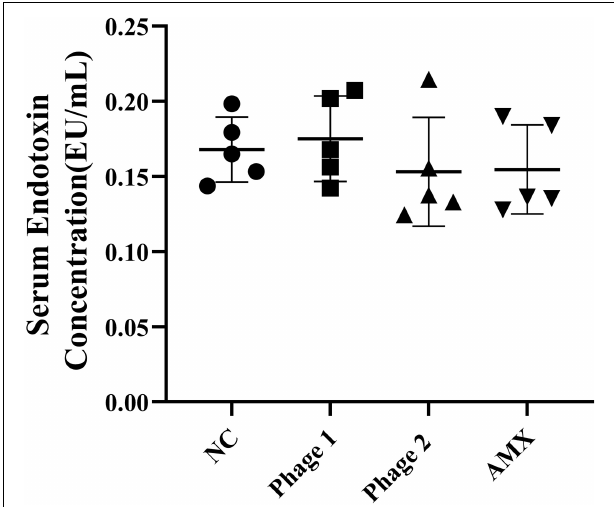
FIGURE 4 | Effect of phage on serum endotoxin in chicks ( n = 5). The serum endotoxin level is an important biomarker of intestinal permeability and was detected using an ELISA kit. NC, negative control; Phage 1, 10 9 PFU GRNsp6 (day 3-5); Phage 2, 10 9 PFU GRNsp6 (day 8-10); AMX, 1 mg/ml amoxicillin (day